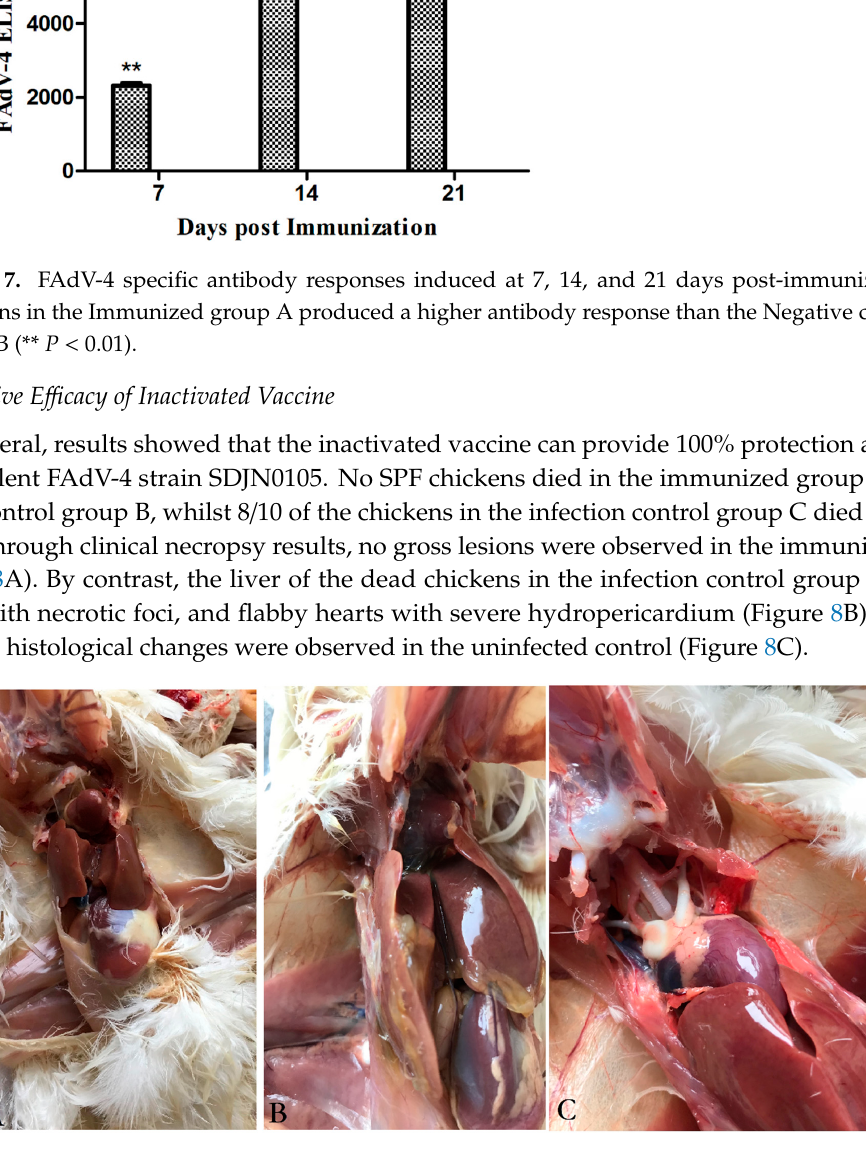
Figure 8. Gross lesions in the liver and heart from chicken challenged with the FAdV-4 strain SDJN0105. ( A ): Liver and heart tissues of challenged chicken immunized with the inactivated vaccine. ( B ): Liver and heart tissues from the infection control chicken. ( C ): Liver and heart from the uninfected